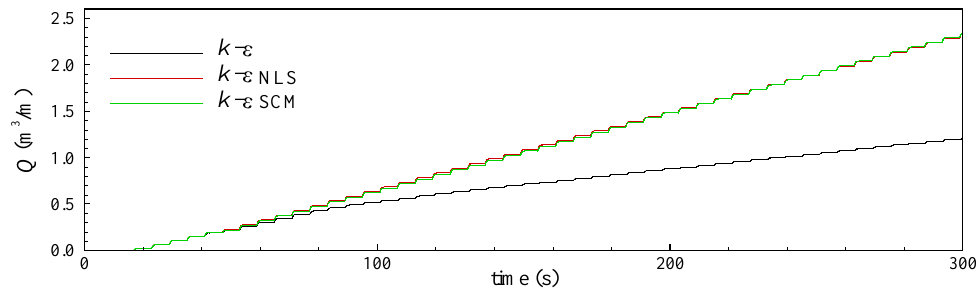
Figure 23. Time series of wave overtopping discharge for k - ε , k - ε NLS and k - ε SCM turbulence models. Table 6. Average wave overtopping discharge for k - ε , k - ε NLS and k - ε SCM turbulence models compared to experimental and numerical values of Losada et al. [15]. Losada et al. [15] FLUENT Exp. Num. k - ε NLS k - ε